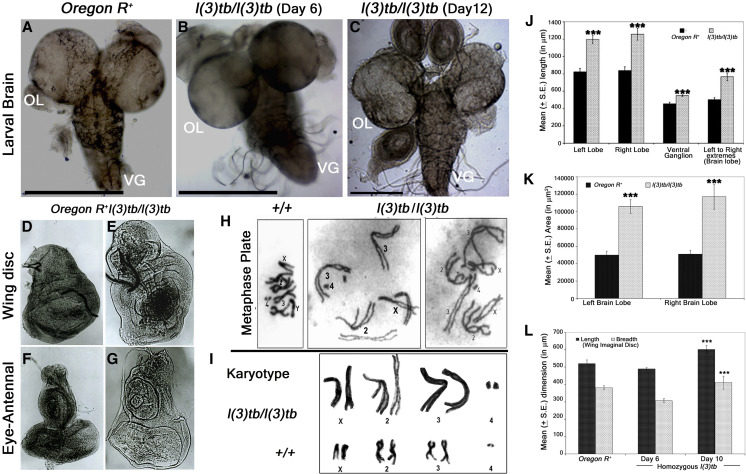
Morphological and chromosomal alterations in l(3)tb homozygotes. Homozygous l(3)tb mutants show severe morphological alteration in delayed 3rd instar larval brain, wing and eye-antennal disc. Homozygous l(3)tb mutant 3rd instar larvae revealed tumorous brain of day 12 (C) as compared to day 6 of homozygous mutant (B) and day 5 of wild type, Oregon R+ (A). l(3)tb homozygotes exhibited highly significant differences in the overall circumference of the left and right brain lobes in the delayed stage (day 10) as compared to the respective wild type brain lobes (J). Significant differences were found in the area (µm2) of respective brain lobes of l(3)tb homozygotes and wild type (K). Dimensions of wing and eye-antennal imaginal discs of delayed 3rd instar larvae from homozygous l(3)tb mutant revealed significant increase in size (D,E,F,G). Length and breadth of wing discs from 3rd instar larvae of l(3)tb mutant of day 6 were found to be smaller than the wing imaginal discs from wild type, but wing discs from extended larval period (day 10) showed significant increase in size (L). Metaphase chromosome preparation of brain cells (H) from wild type and l(3)tb homozygotes exhibited abnormal karyotypes (I) where l(3)tb homozygotes showed less condensed and extended chromosome morphology as compared to wild type, Oregon R+. *** denotes P < 0.005.